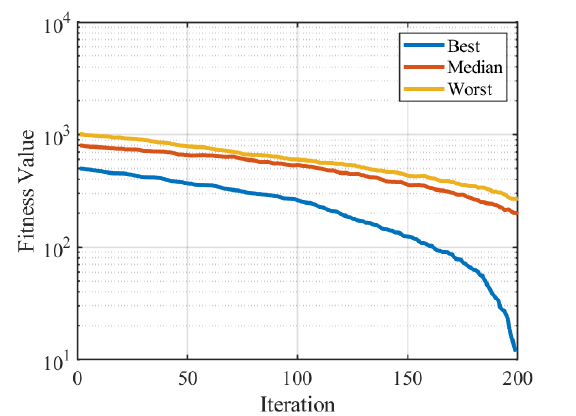
Figure 13. Typical progress of the equilibrium for 8 sonications with 20